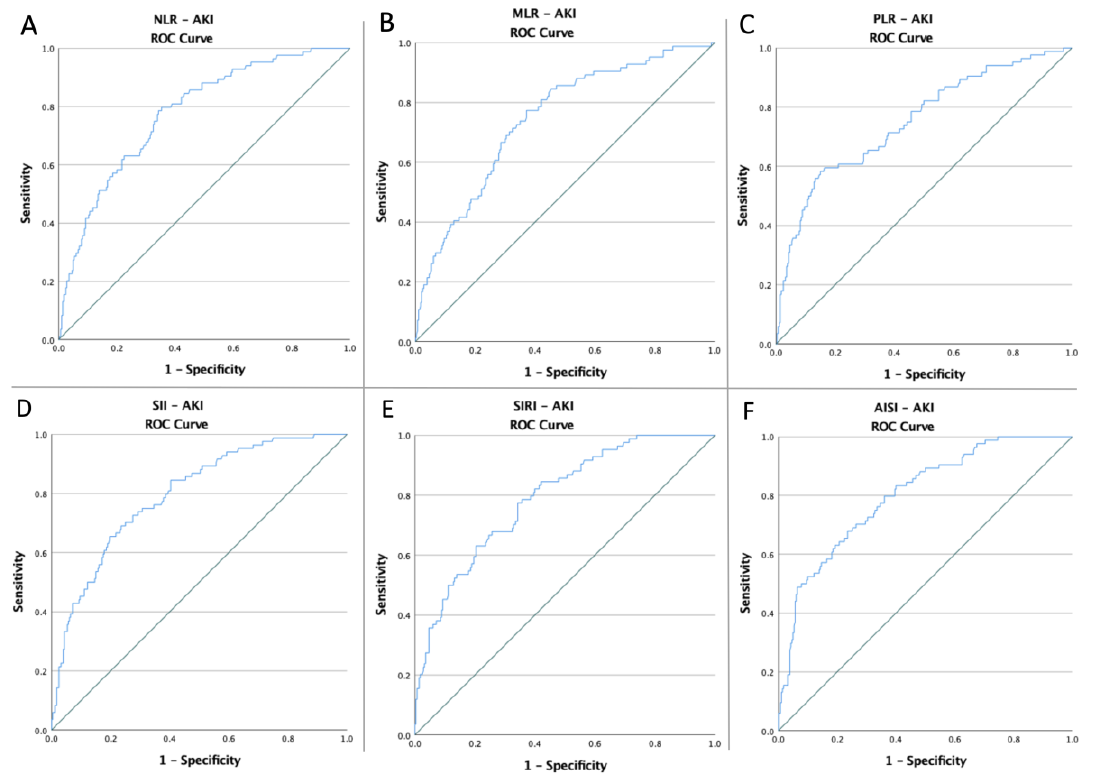
Figure 1. ROC curve analysis concerning the AKI risk ( A ) NLR (AUC: 0.777; p < 0.0001), ( B ) MLR (AUC: 0.744; p < 0.0001), ( C ) PLR (AUC: 0.751; p < 0.0001), ( D ) SII (AUC: 0.796; p < 0.0001), ( E ) SIRI (AUC: 0.790; p < 0.0001), and ( F ) AISI (AUC: 0.802; p < 0.0001); blue line – ROC curve; green line – diagonal line.